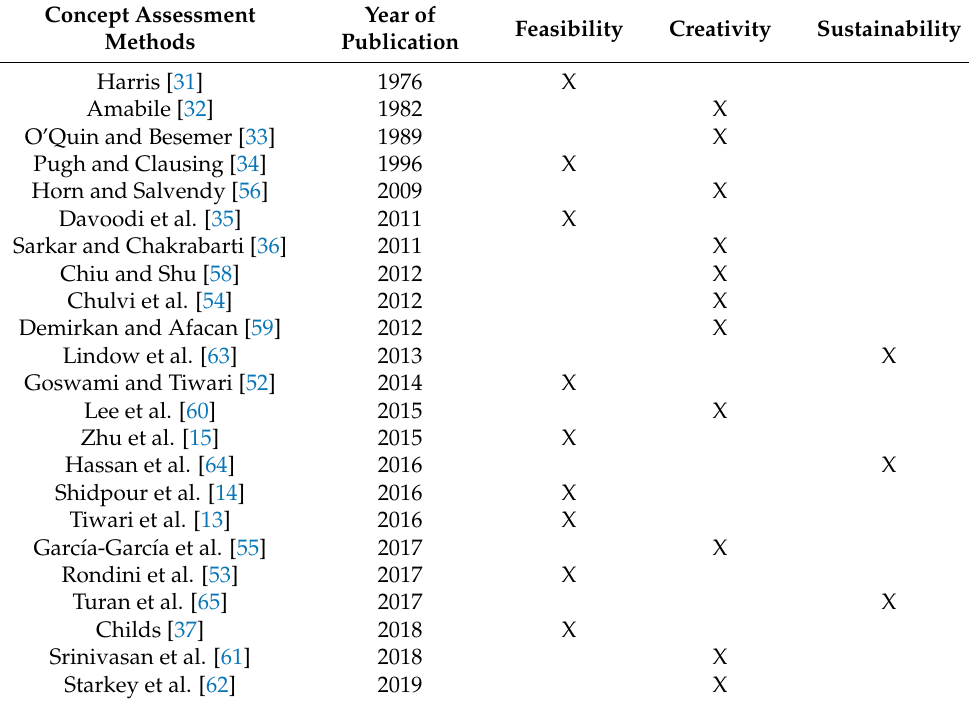
Table 1. Summary of concept assessment methods for product